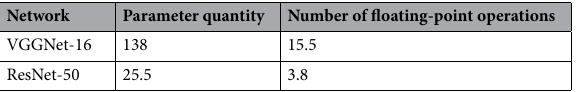
Table 1. Comparison of network complexity between VGGNet-16 and ResNet-50.